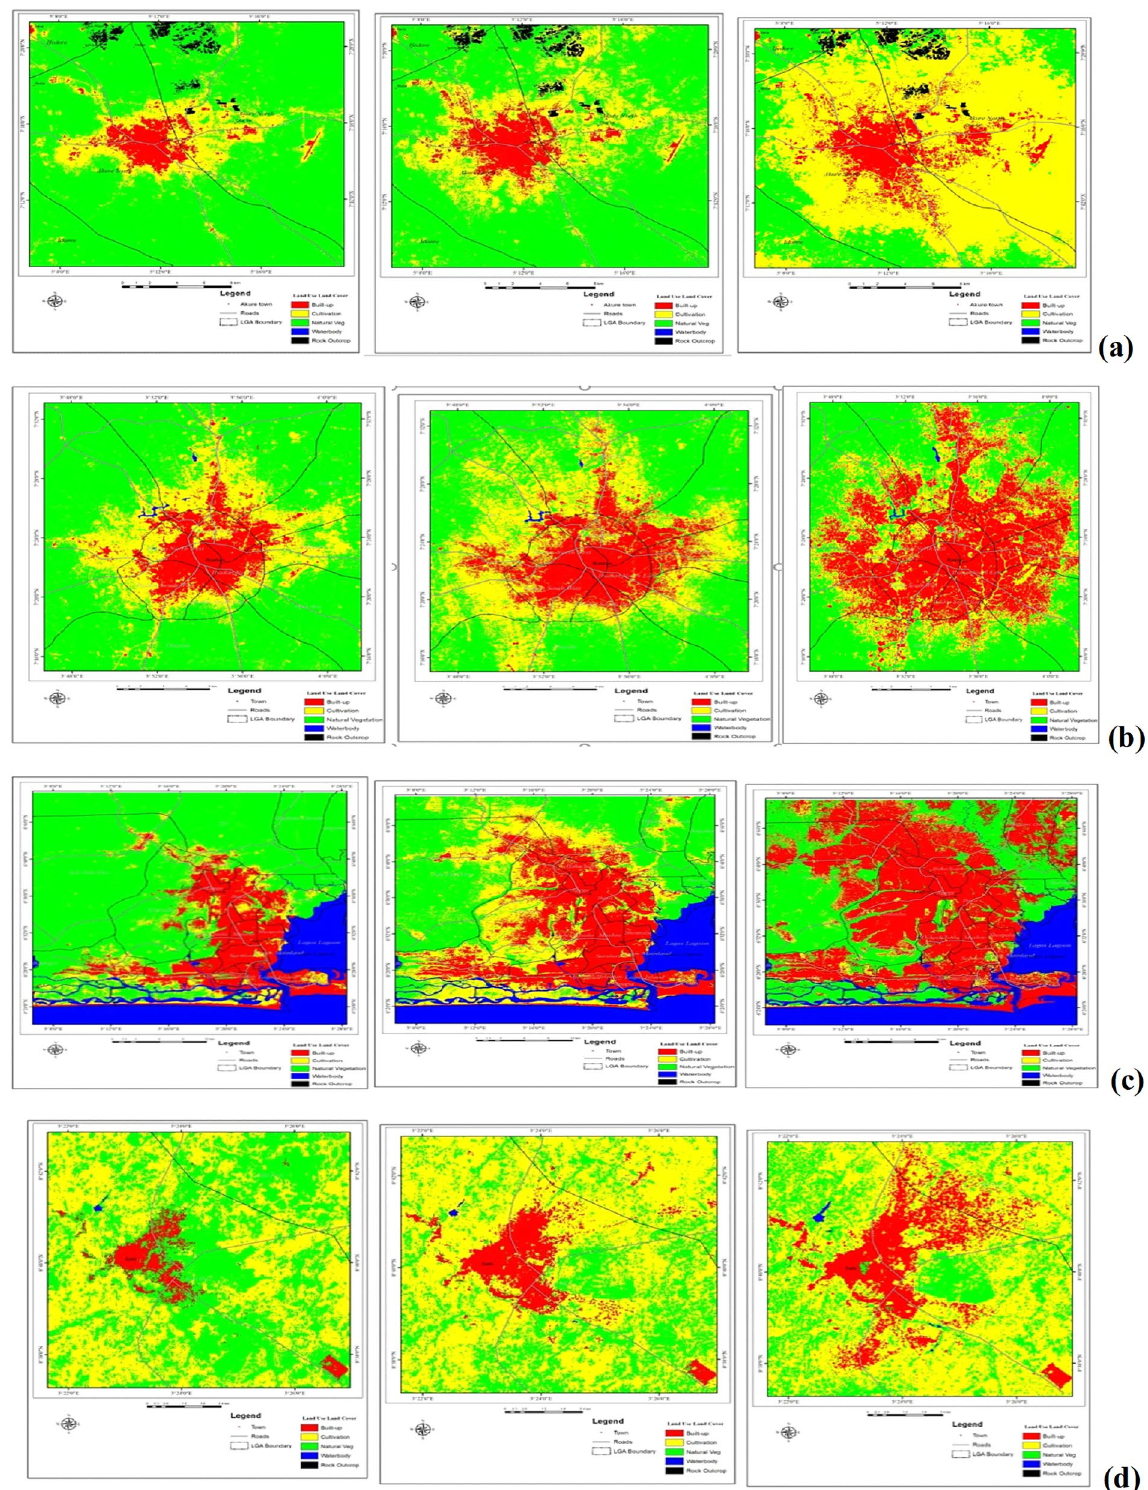
Figure 7. Land use/land cover classification ( a ) Akure; ( b ) Ibadan; ( c ) Lagos; and ( d ) Saki; 1984, 2004 and 2019. The Figure was generated using ArcGIS 10.5 software (http:// www. esri.